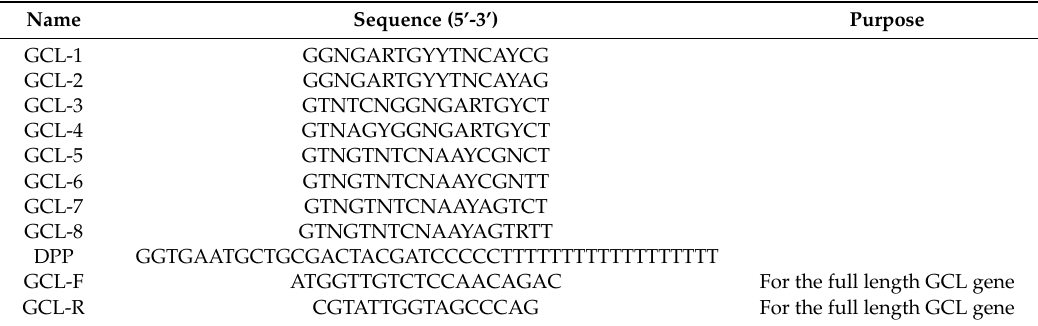
Table 1. Primers for amplification of Grateloupia chianggi lectin